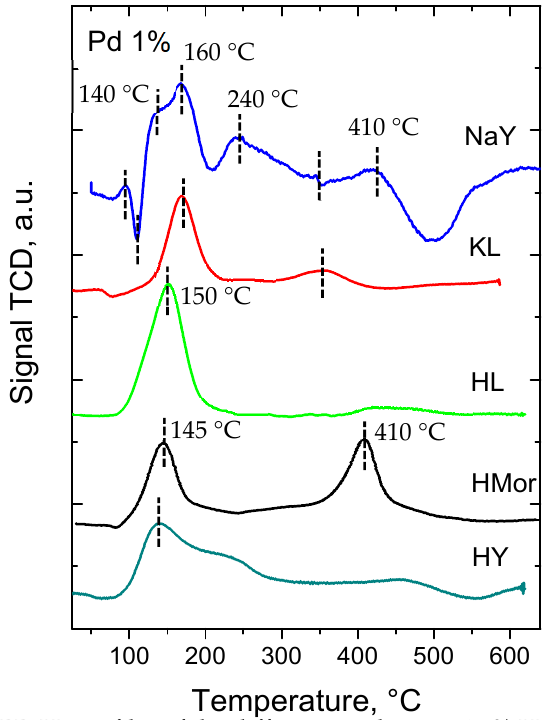
Figure 2. TPR-H 2 profiles of the different catalysts in 4.8% H 2 /Ar, 10 °C/min.